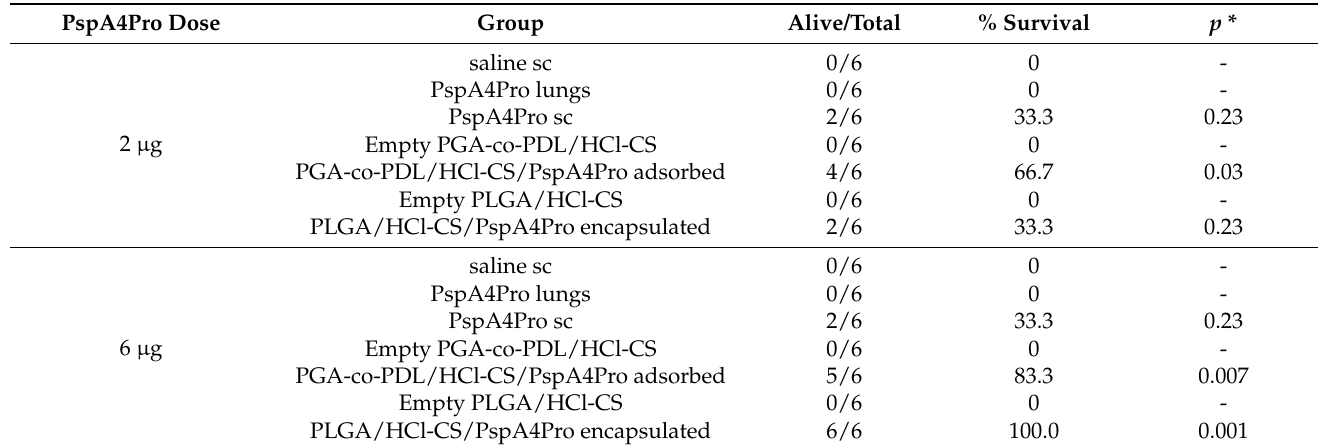
Table 5. Survival after lethal challenge with ATCC6303. PspA4Pro